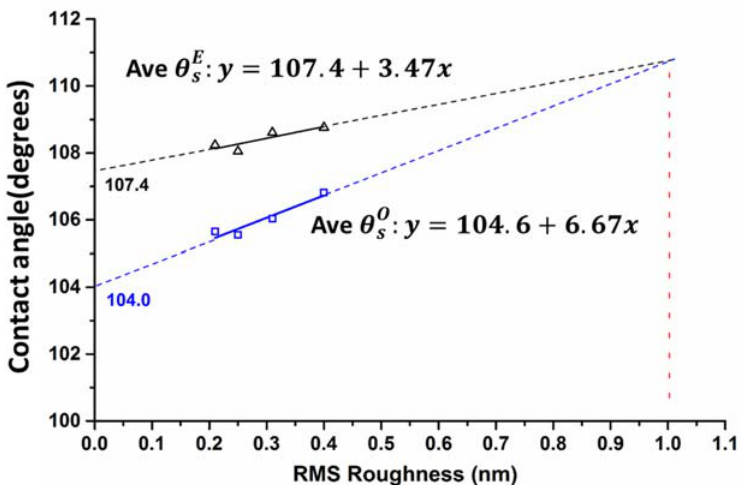
Figure 9. Comparing the substrate roughness with the average contact angles measured on odd and even SAMs. Dashed lines are fitted lines showing the effect of surface roughness on the odd-even